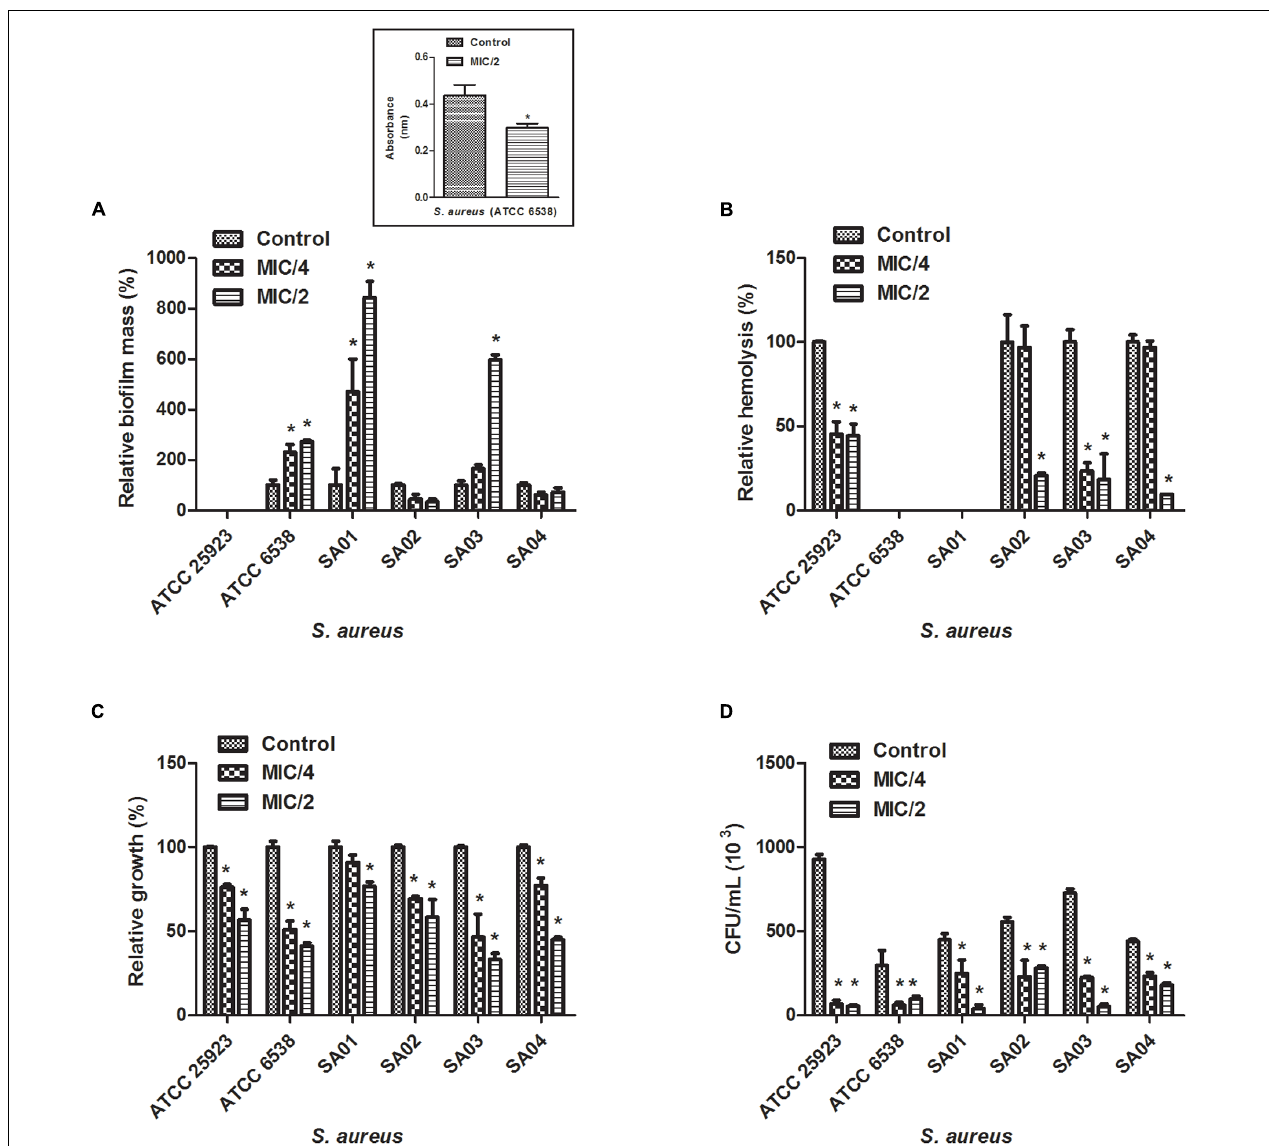
FIGURE 1 | Effect of cinnamaldehyde (MIC/2 and MIC/4) on virulence factors of Staphylococcus aureus strains. (A) Biofilm mass production; (B) Hemolytic activity; (C) Serum resistance; (D) Adhesion to latex (catheter). Inset box indicates bacterial viability. ∗ p < 0.05, compared with vehicle-treated controls. Experiments were performed three times in duplicate. Each bar represents mean +